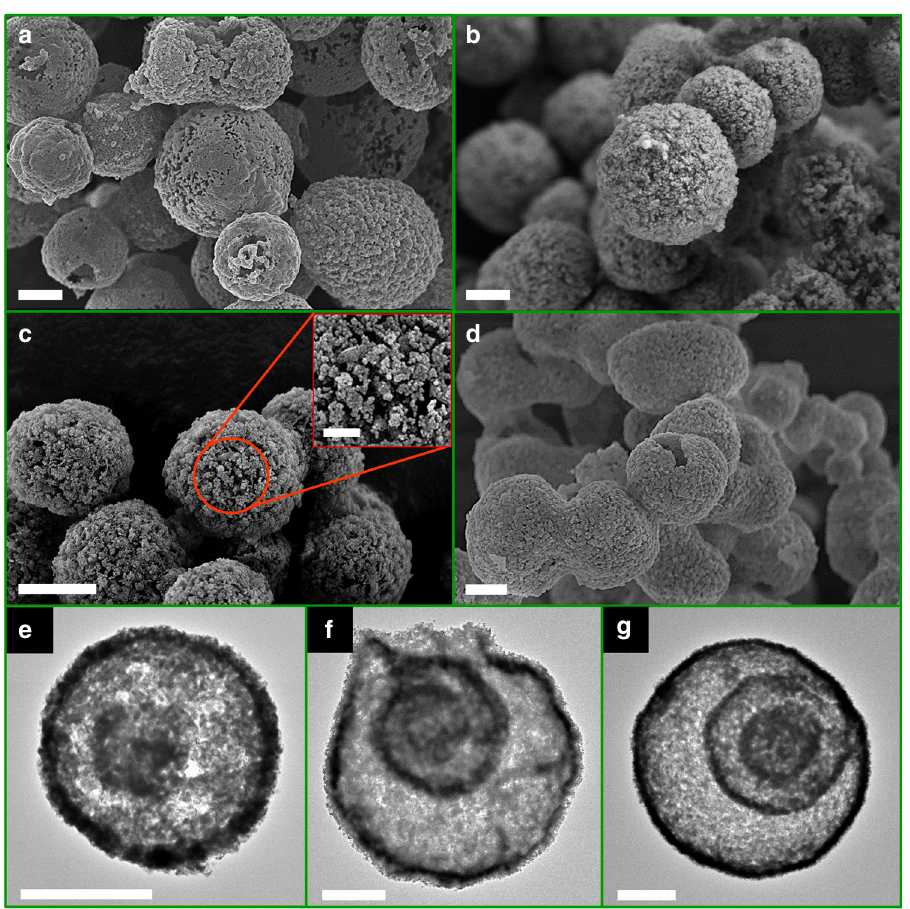
Fig. 2 Formation of porous multishelled structures. SEM and TEM images of the hydrothermally synthesized sorbents after thermal removal of the